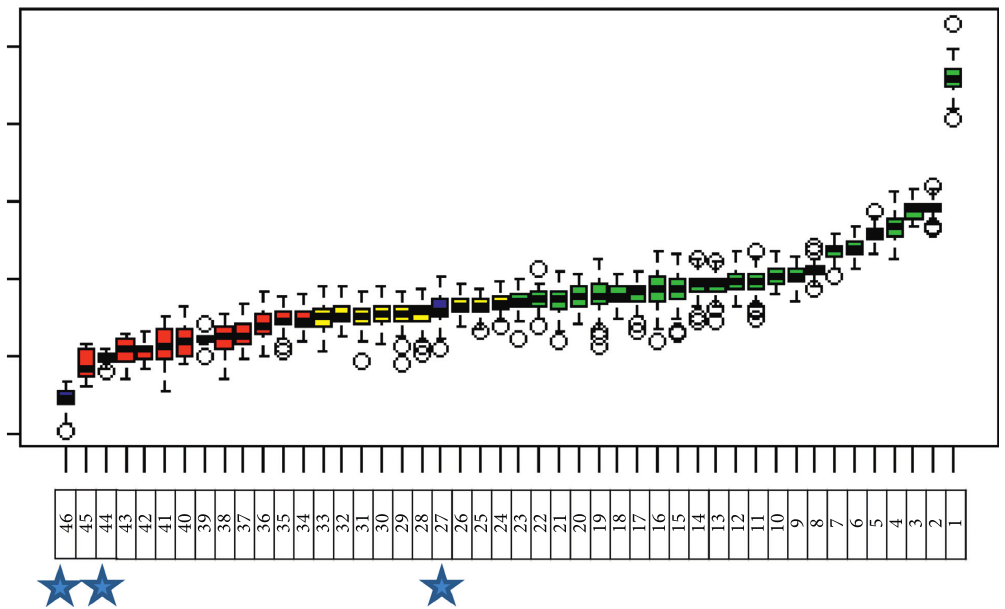
Figure 4: The importance scores of AVL variables. Table 4: Boruta ranking of AVl